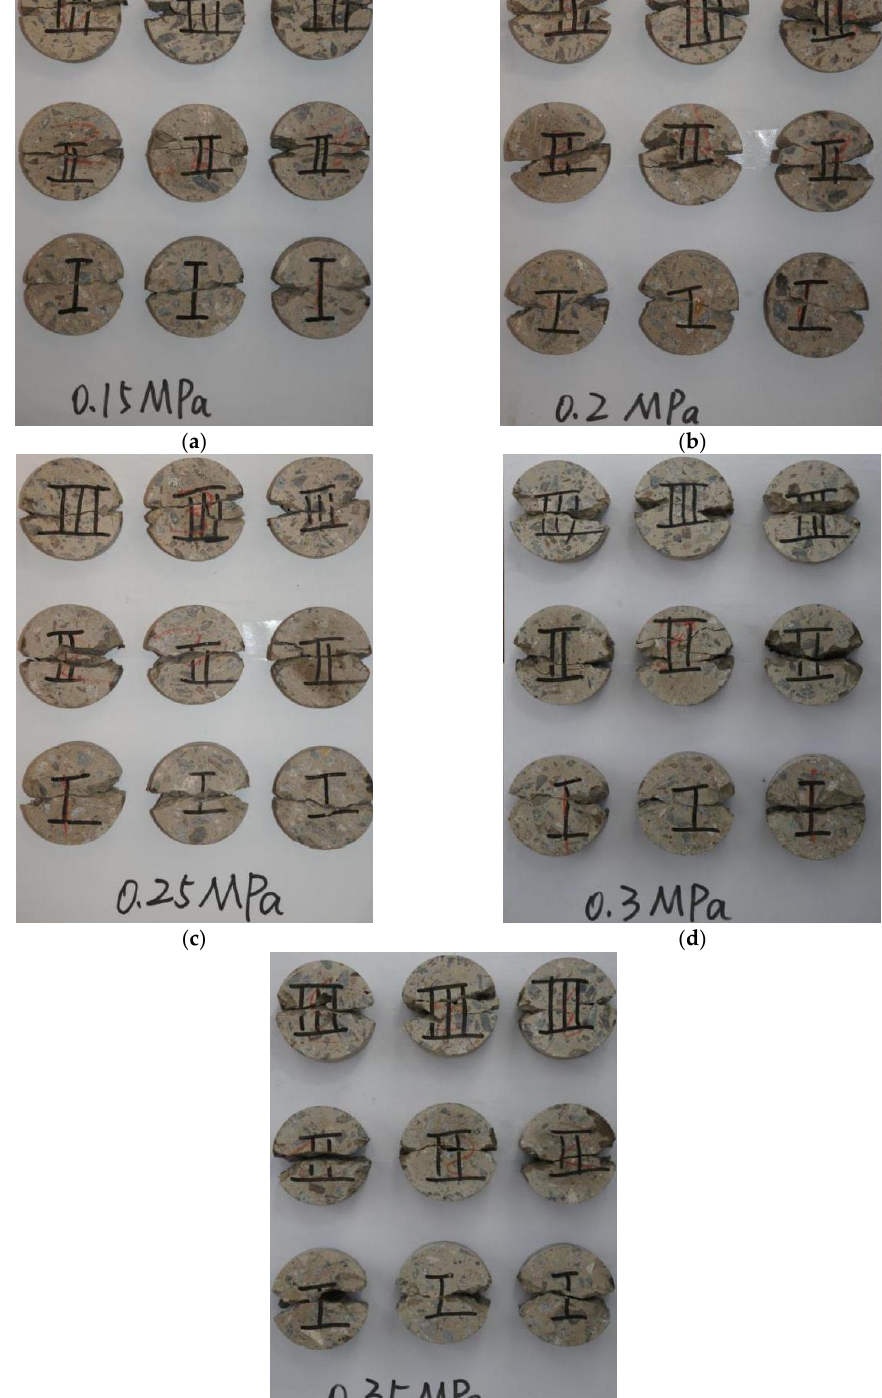
Figure 4. Failure patterns of three series of concrete specimens under different impact velocities: ( a ) v = 5.88 m/s; ( b ) v = 7.38 m/s; ( c ) v = 9.26 m/s; ( d ) v = 10.46 m/s; ( e ) v = 11.37 m/s.